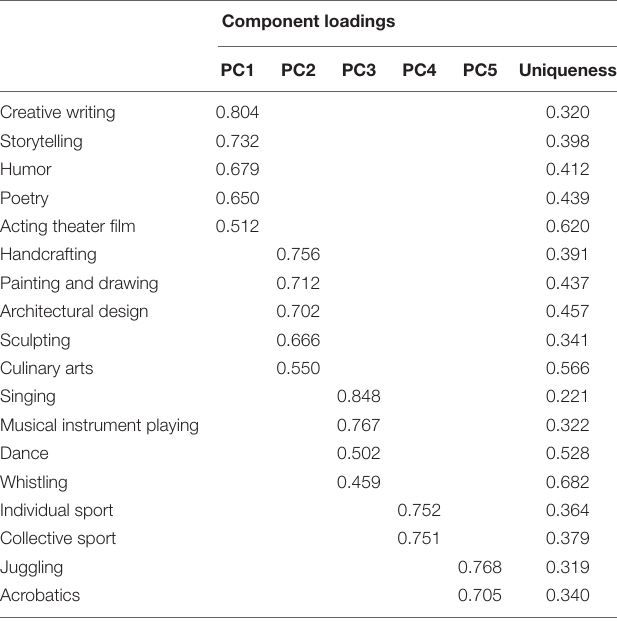
TABLE 1 | Factor loadings of the 18 leisure activities after principal component